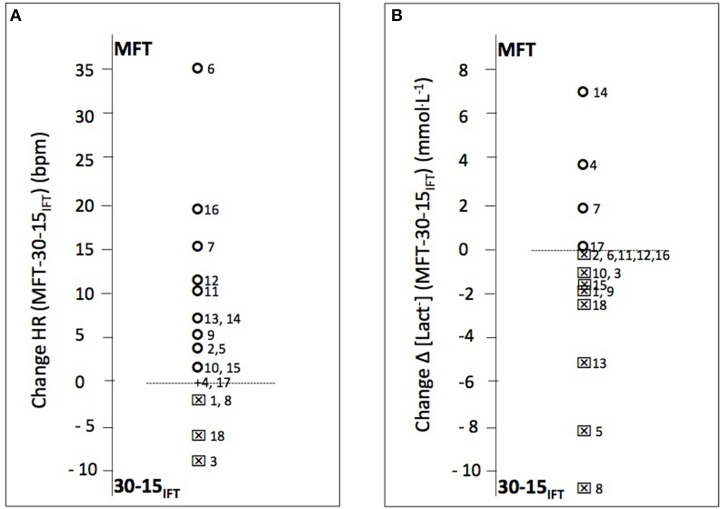
Individual wheelchair basketball players difference in peak heart rate and blood lactate values between continuous multistage field test (MFT) and 30-15 intermittent field test (30-15IFT) (n = 18). (A) Difference HR (bpm) and (B) Difference Δ[Lact−], respectively represented the difference in peak values of heart rate (bpm) and Δ blood lactate (peak-rest values [La−] mmol·L−1). A circle plots indicated a difference between MFT and 30-15IFT values in favor of MFT; a square worth the 30-15IFT.